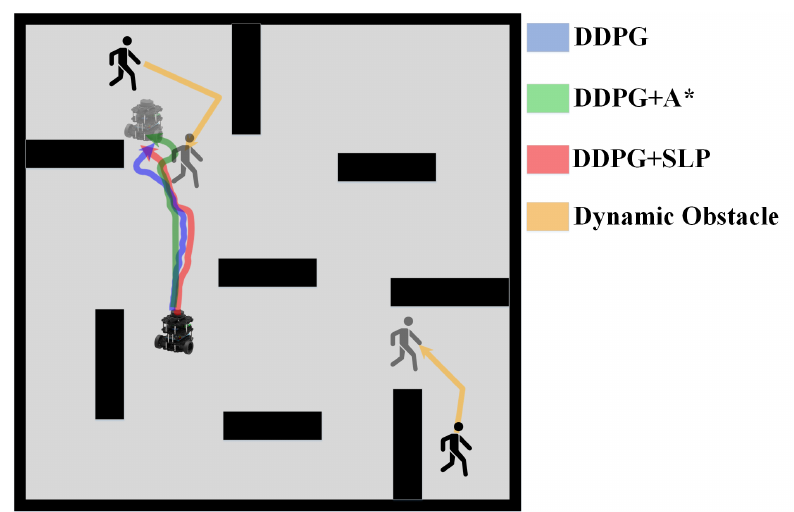
Figure 11. Robot Trajectory of Different Method in Dynamic Environment.